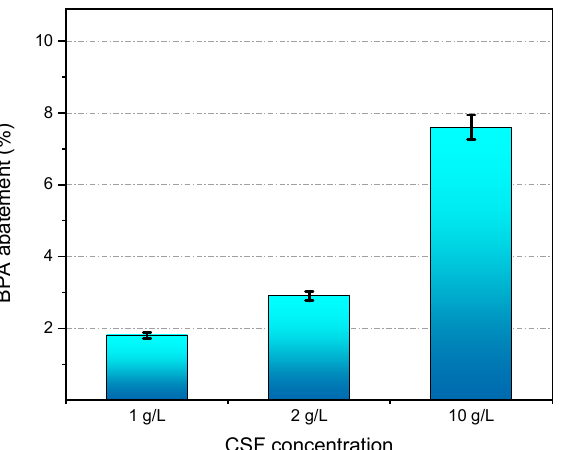
Figure 7. Abatement of BPA in the concentrated wastewater effluent after treatment with different amounts of CSF for 5 h.